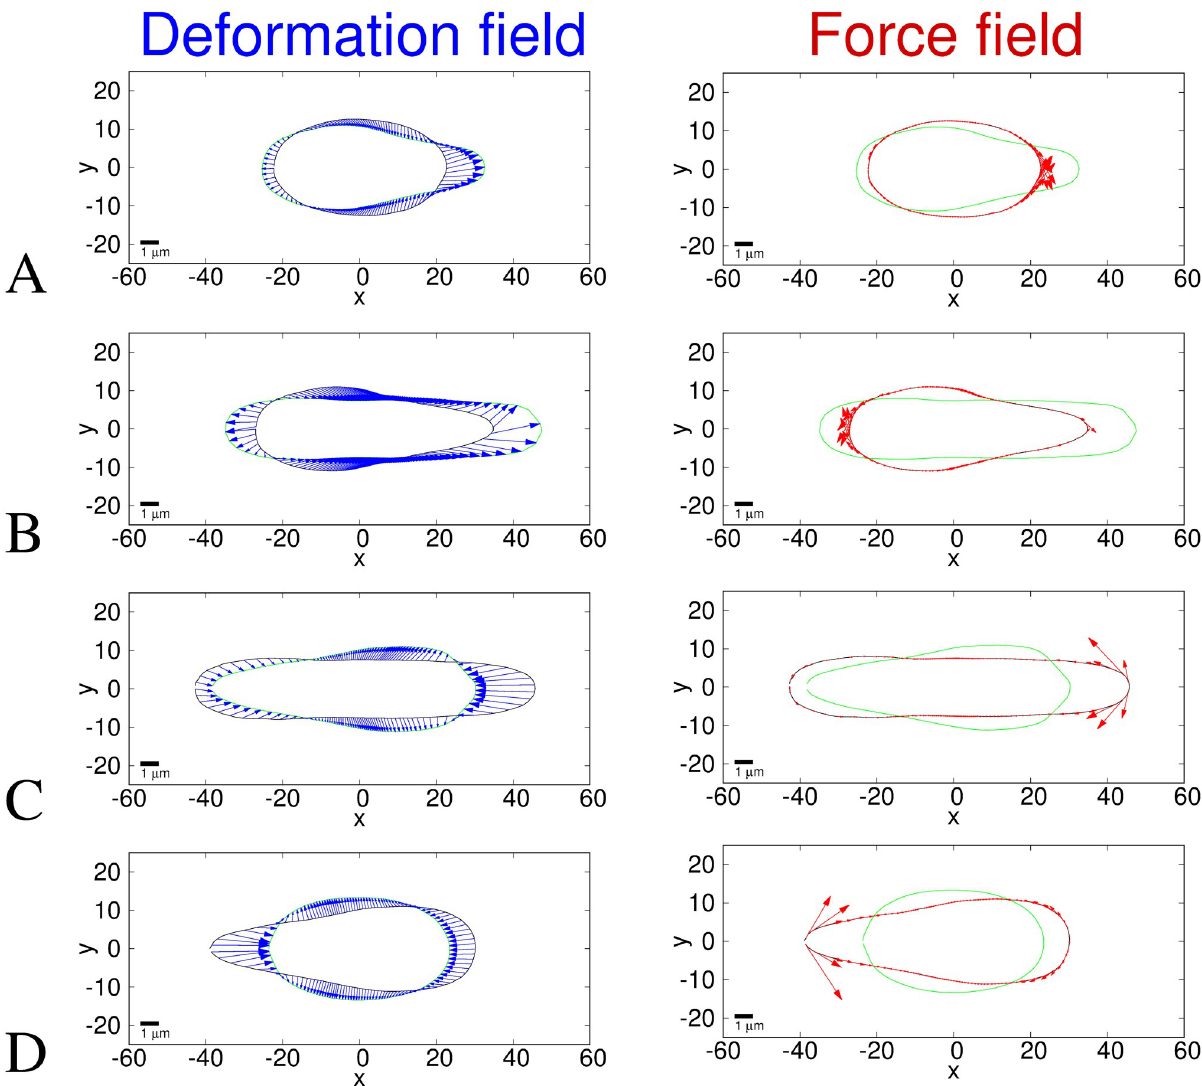
Fig 6. Deformation (left) and traction force (right) fields for the shell model. The axes show pixel numbers where each pixel is 0.215 μ m. The black outline is the initial shape and the green outline is the target deformed shape. Blue arrows represent the final deformation field found between the images and red arrows represent the traction force direction and magnitude, with each arrow scaled such that one unit of length on the axes represents a traction force of 250 Pa. The traction force is calculated using E = 5 kPa and assuming that the nucleus behaves as an incompressible elastic shell with a Poisson ratio ν = 0.5. Average shapes the same as in Fig 4, i.e. A. before to entering constriction, B. entering to within constriction, C. within to exiting constriction and D exiting to after constriction. Since the shapes are averages they do not correlate directly to any single nucleus, however experimental images of a typical nucleus are shown for comparison in Fig 1. As in Fig 4, the target shape is moved − 1.7, − 7.3, 0.15, 0.0 pixels along the x direction, from the centroid aligned position for A-D respectively (see Appendix D in S1 Text). A discussion is provided in the main text of the differences between the deformation field and traction forces between the shell model (shown in this figure) and the solid model (shown in Fig